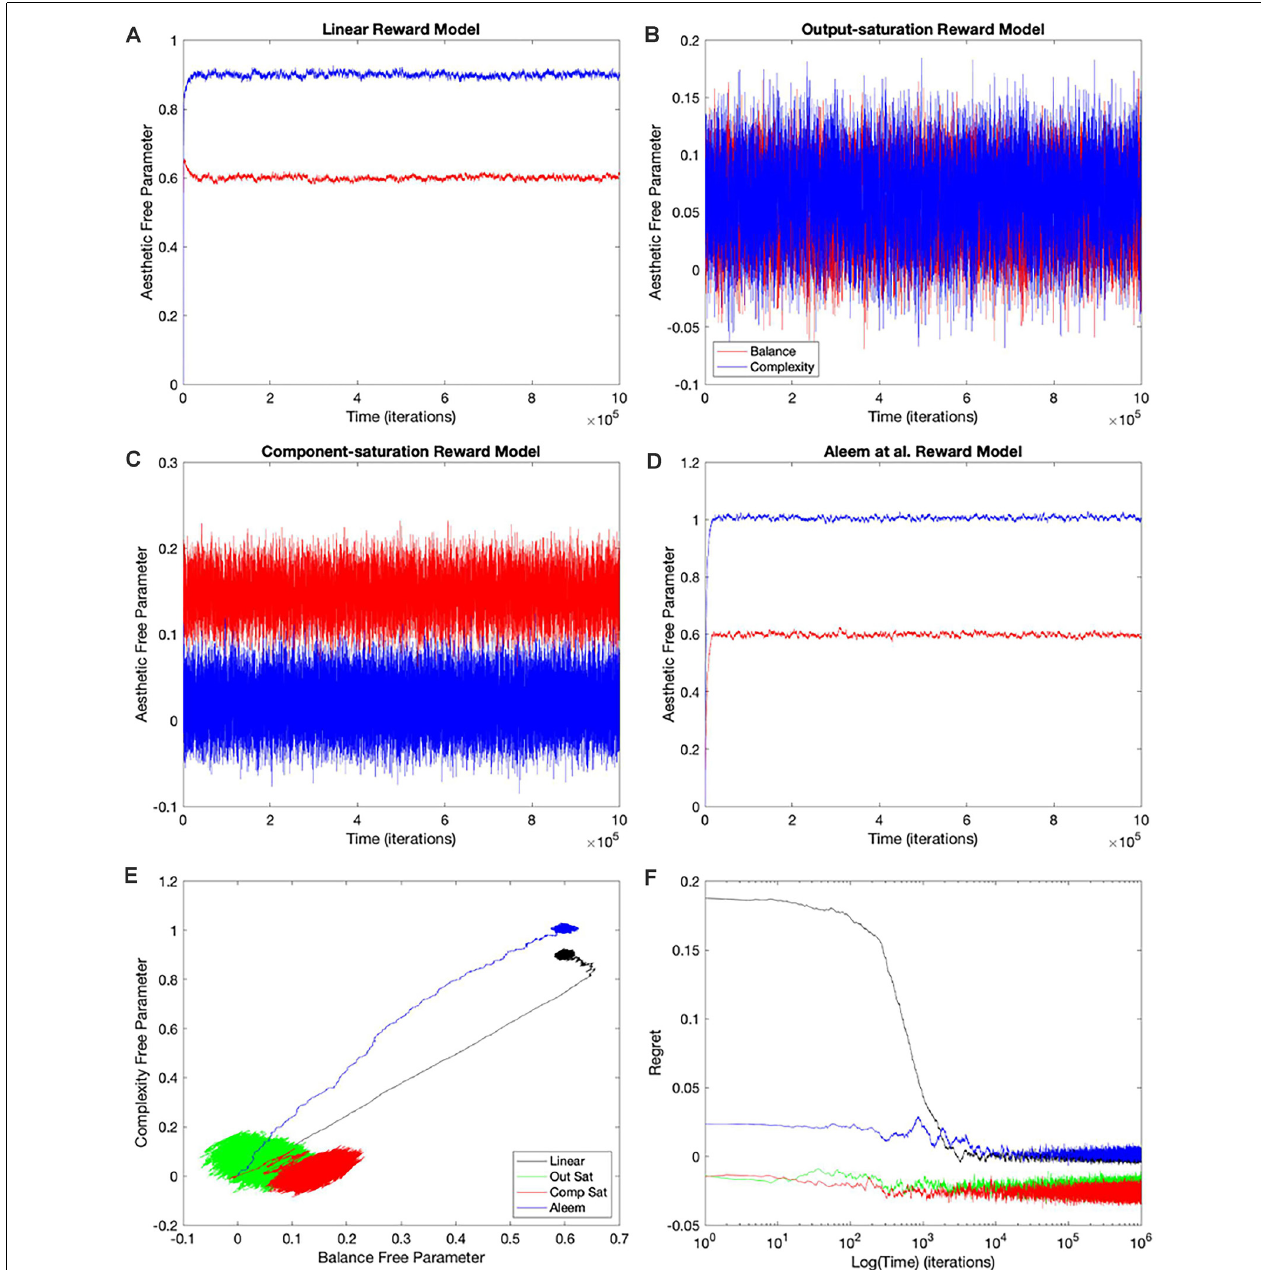
figure are the same as those for Figure 2